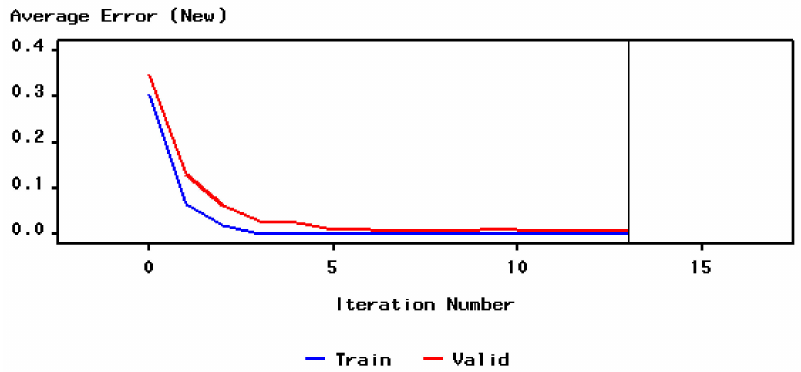
Figure 6. The evolution of both the training error and the validation error.